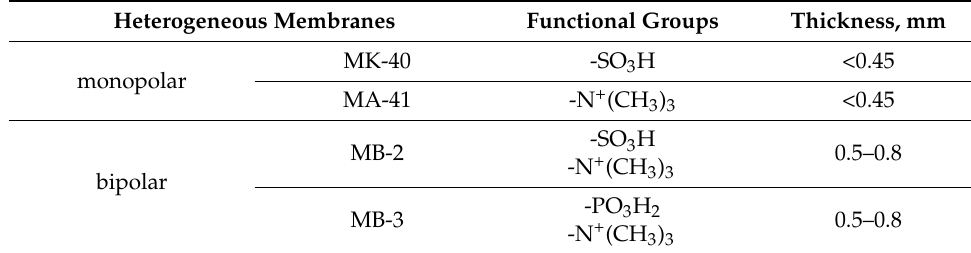
Figure 3. Diagram of an electrodialysis apparatus with a three-chamber unit cell for obtaining sulfuric acid and sodium hydroxide solutions: ( a ) — for the first and second variants of the experiment; ( b ) — for the third variant of the experiment (description is in the main text). CEM, cati on-exchange membrane, AEM, anion-exchange membrane, BM, bipolar membrane; n is an elementary repeating fragment. Table 1. Characteristics of the ion-exchange membranes used in the study [32].